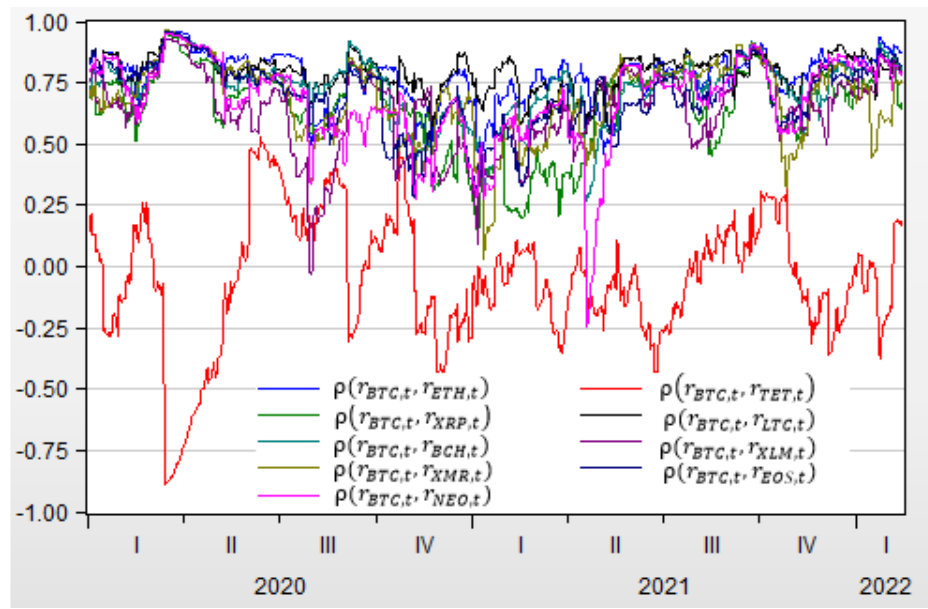
Figure 7. Curves of the DCC between Bitcoin and the other nine cryptocurrencies for the COVID-19 period.